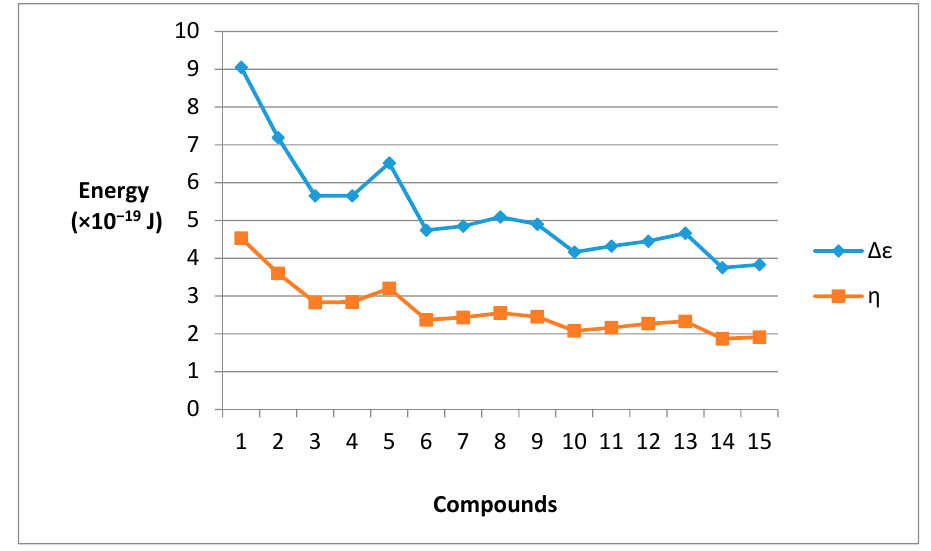
Figure 5. Variation of Δ HOMO–LUMO and chemical hardness in tropylium cation and its mono- and poly-phospha analogues.